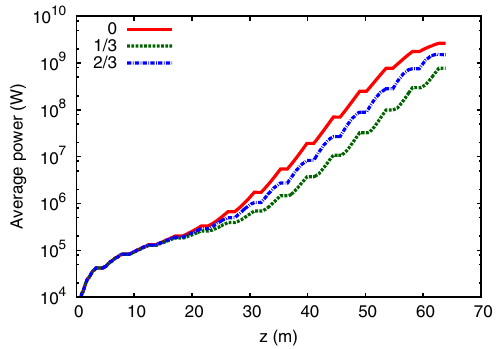
FIG. 2. Average power at the fundamental ( 3 λ 0 ) produced as a function of distance resulting from fixed phase shifters with shifts of 0, 1 = 3 , and 2 = 3 of a